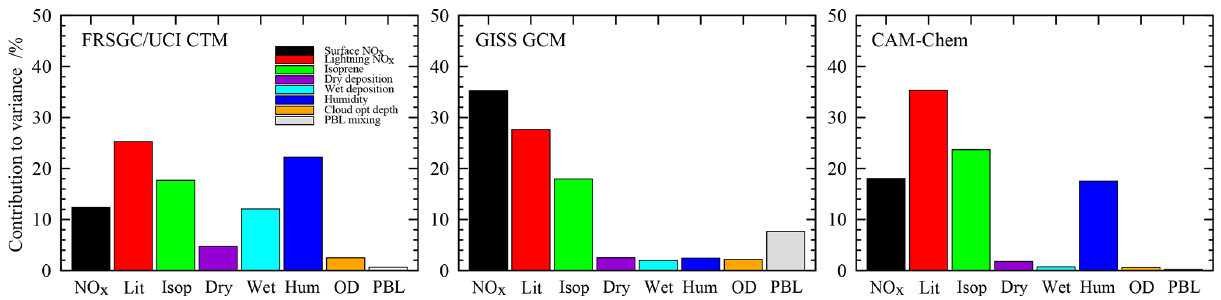
Figure 4. Contributions of each variable to the total variance in the simulated annual mean CH 4 chemical lifetime in each